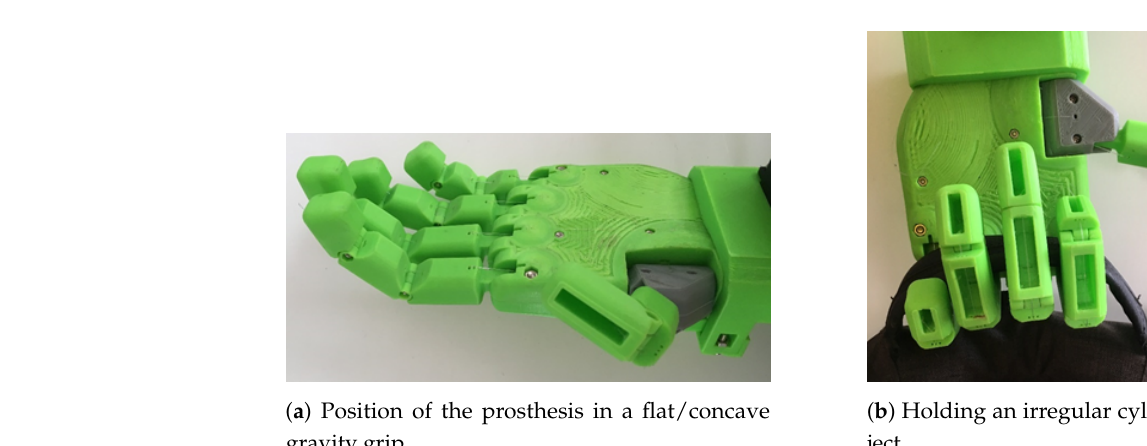
Figure 15. Hook gravity grip holding a backpack.